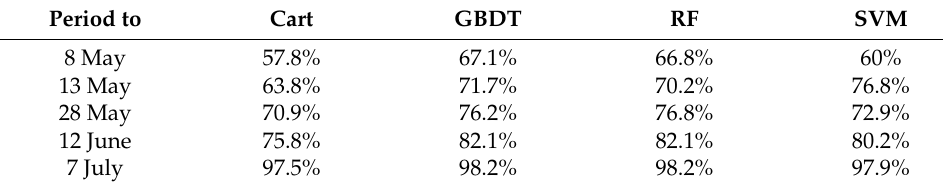
Table 17. Accuracy of corn identification in 2020 different